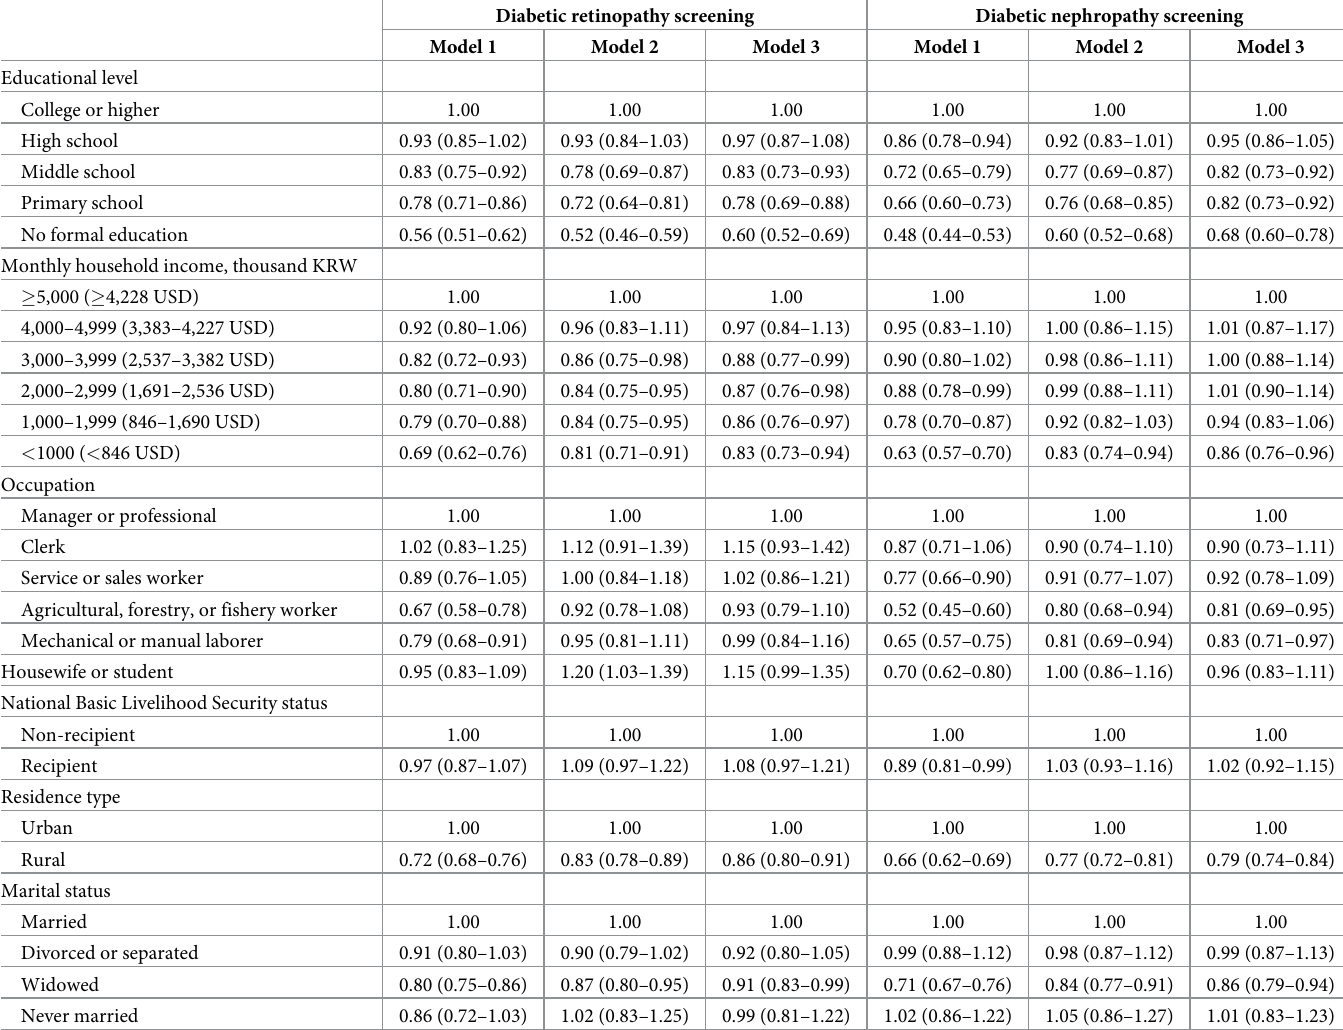
Table 3. Relationships between socioeconomic status indicators and screening for diabetic retinopathy and nephropathy (n = 22,134).